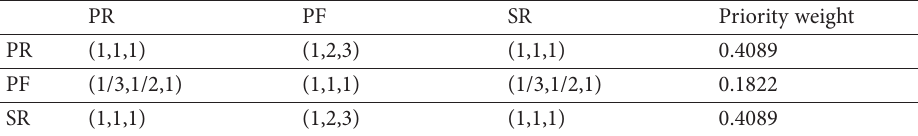
Table 9. Fuzzy evaluation of sub-factors as to perceived risk